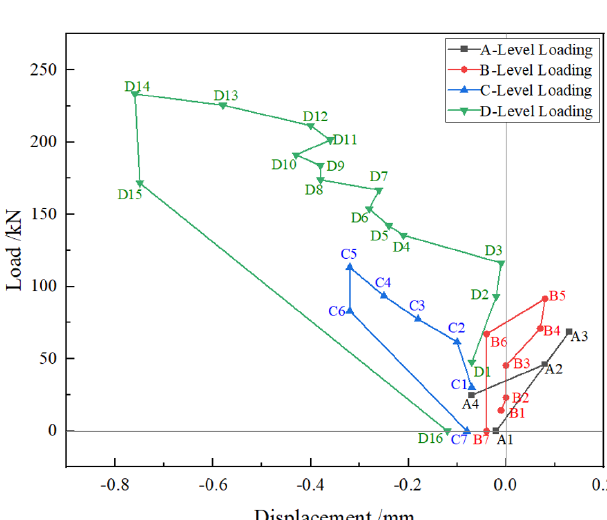
( b ) Figure 13. Strain of floor and side wall. ( a ) strain of floor; ( b ) strain of side wall Figure 14a–c shows the strain changes of the arch toe, arch waist, and vault of the lining structure. It can be seen from Figure 14a that in the early stage of loading in the fourth stage, the strains of the left and right arch feet were similar. The compressive strain appeared on the left side and the tensile strain appeared on the right side. When loaded